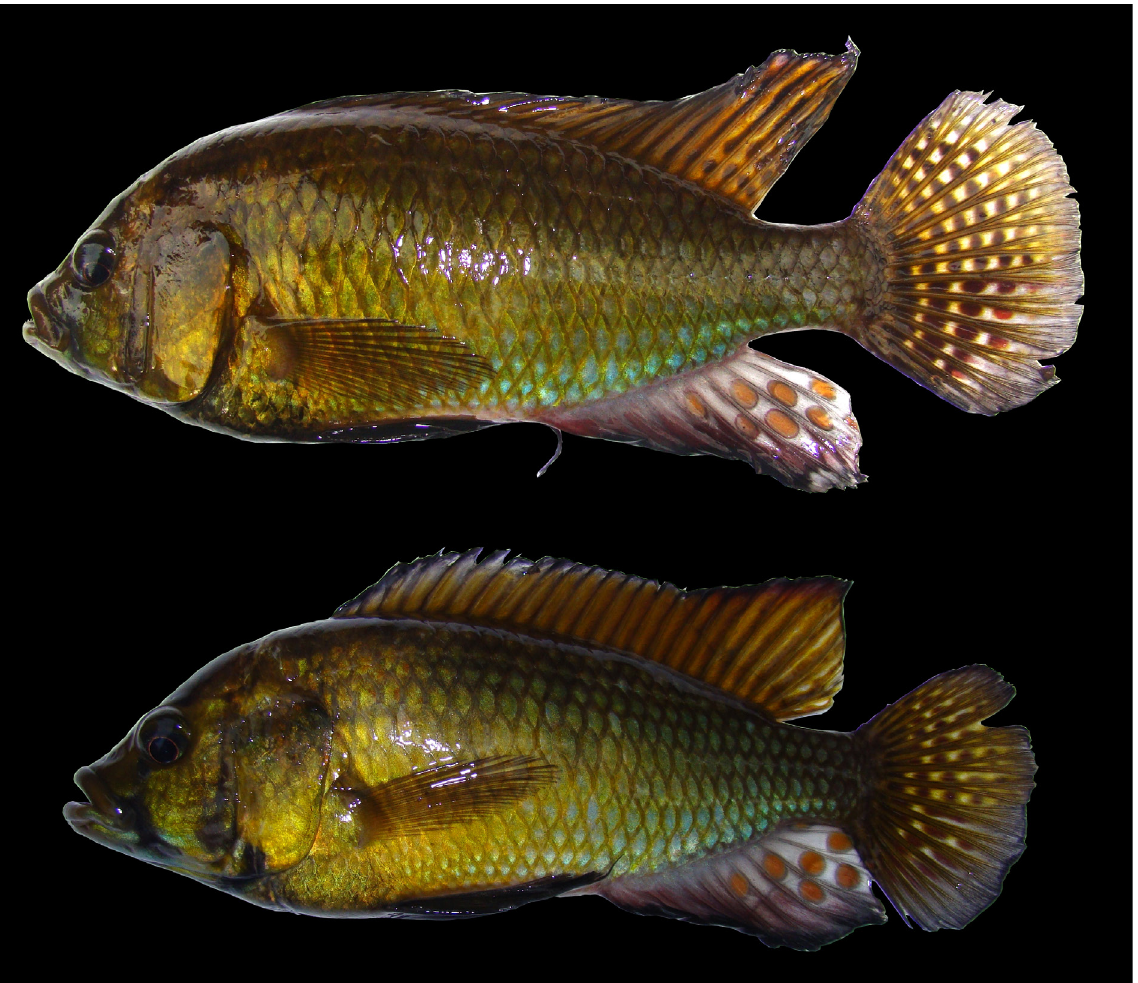
Fig. 5. Adult ♂♂ of Astatoreochromis alluaudi Pellegrin, 1904 caught on 15 Dec. 2012 at Kumana village, Nyagisozi zone, Lake Rweru, Upper Akagera (Rwanda), 115,3 mm SL and 100,4 mm SL not catalogued. (Photographs by